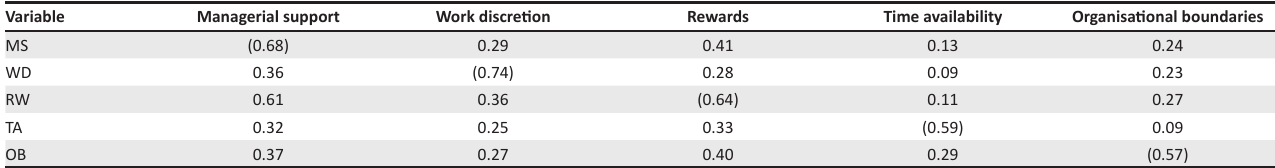
TABLE 5: Factor and scale correlations of the Brief Corporate Entrepreneurship Assessment Instrument.